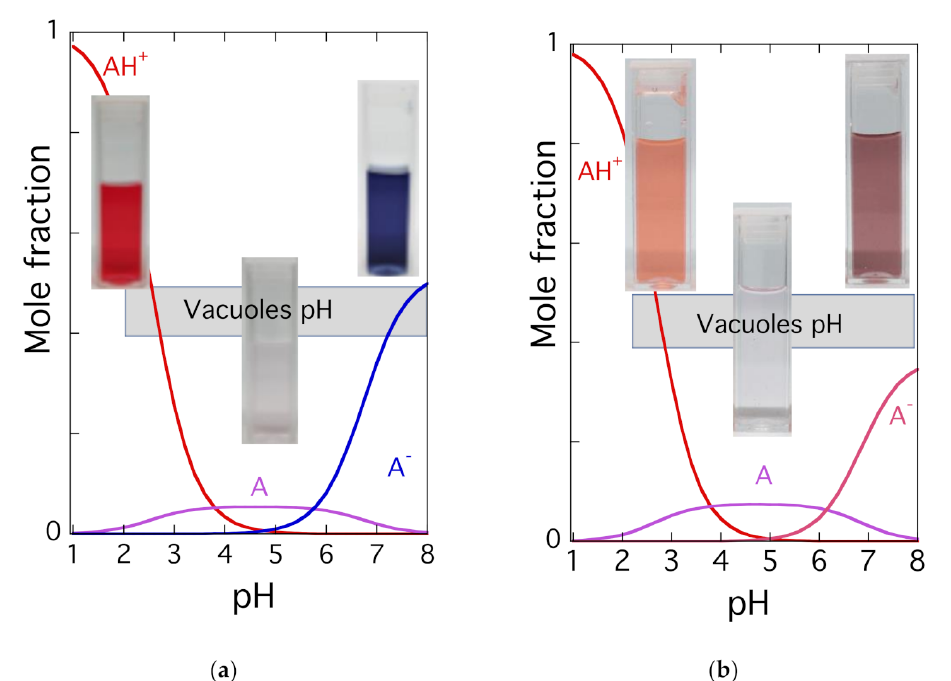
Figure 4. ( a ) Mole fractions at the pseudo-equilibrium of the colored forms of oenin ( b ) and kuro- manin; in this case the blue color is observed only for the dianionic quinoidal base (not shown).